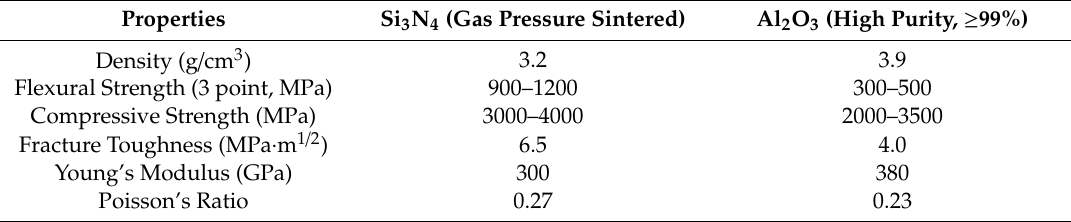
Table 1. Comparison of material properties between Si 3 N 4 and Al 2 O 3 (commercial reference values).